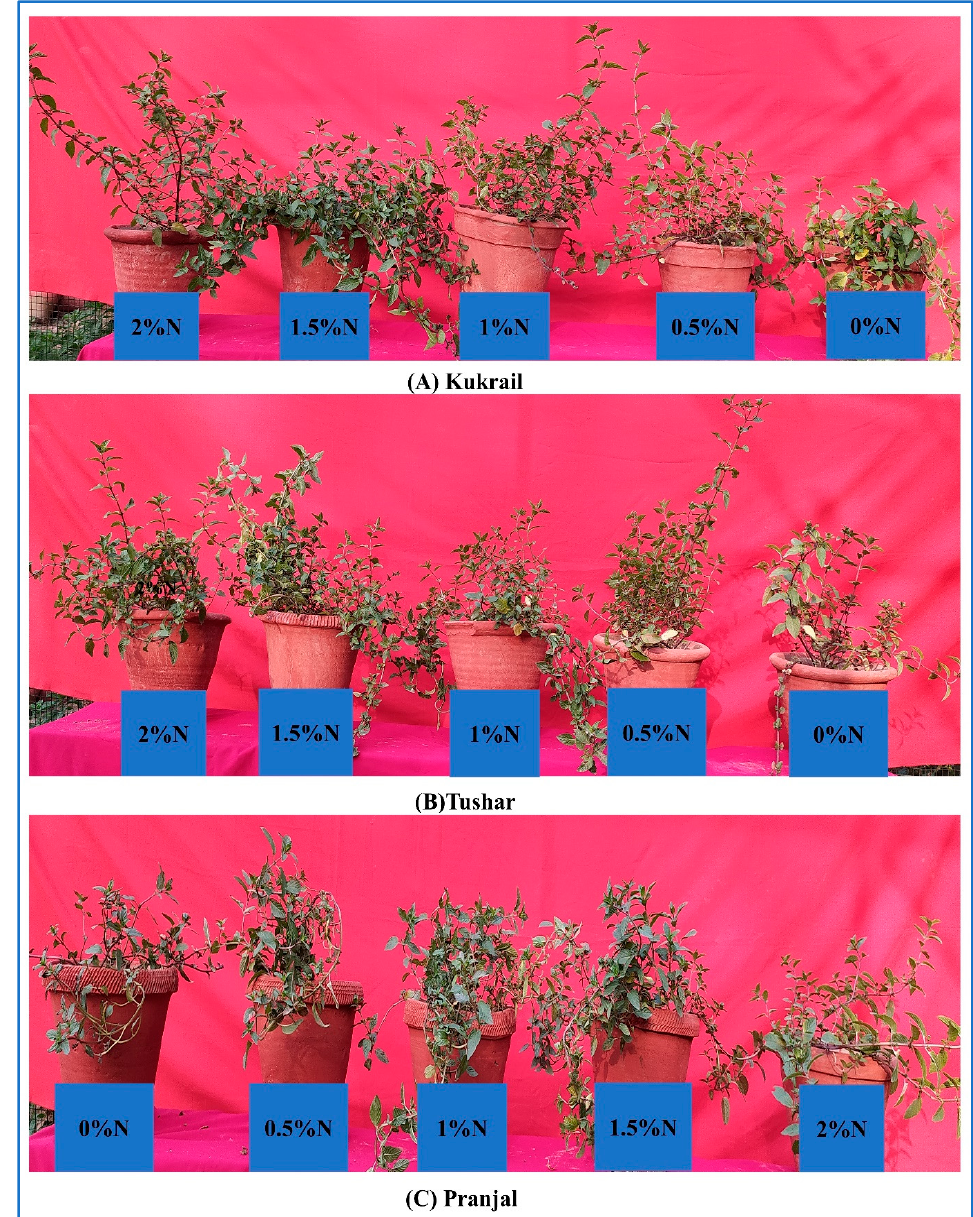
Figure 17. Representative experimental plants of the three cultivars of peppermint.